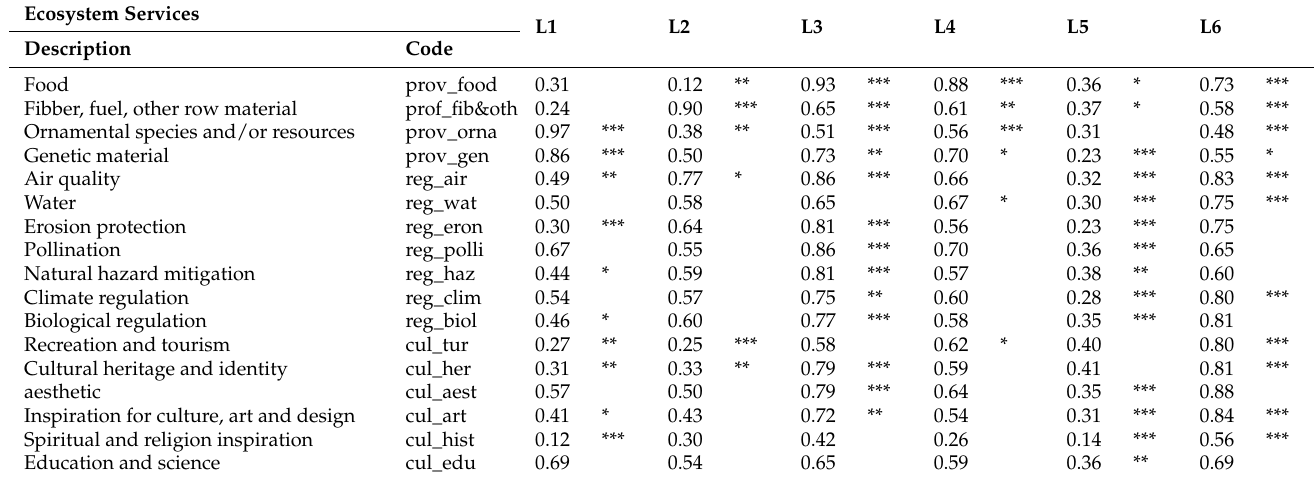
Table 1. The contribution of selected landscapes to different ES (number of interviews = 28). Ecosystem Services